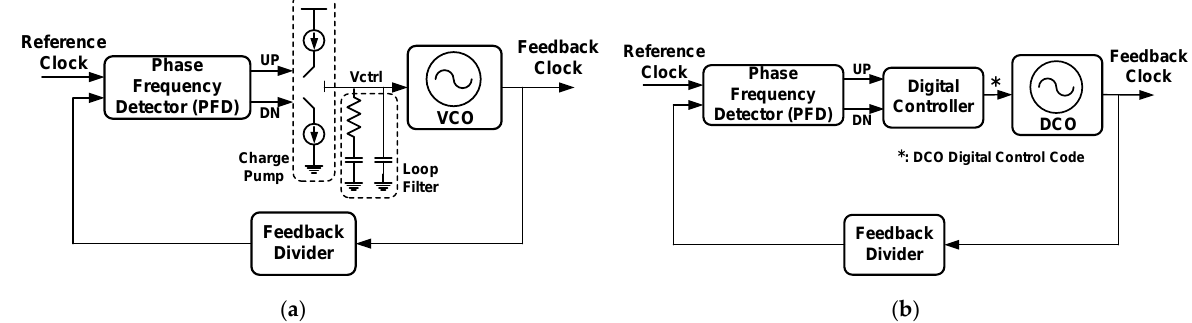
Figure 1. ( a ) Functional block diagram of a general phase-locked loop (PLL); ( b ) Functional block diagram of a general all-digital PLL (ADPLL).